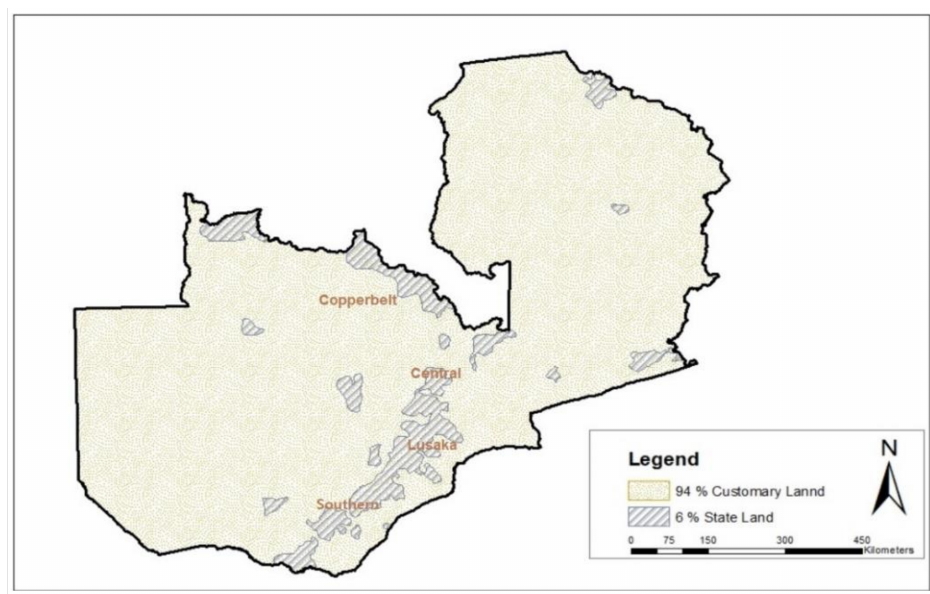
Figure 1. Distribution percentage of state land and customary land in Zambia